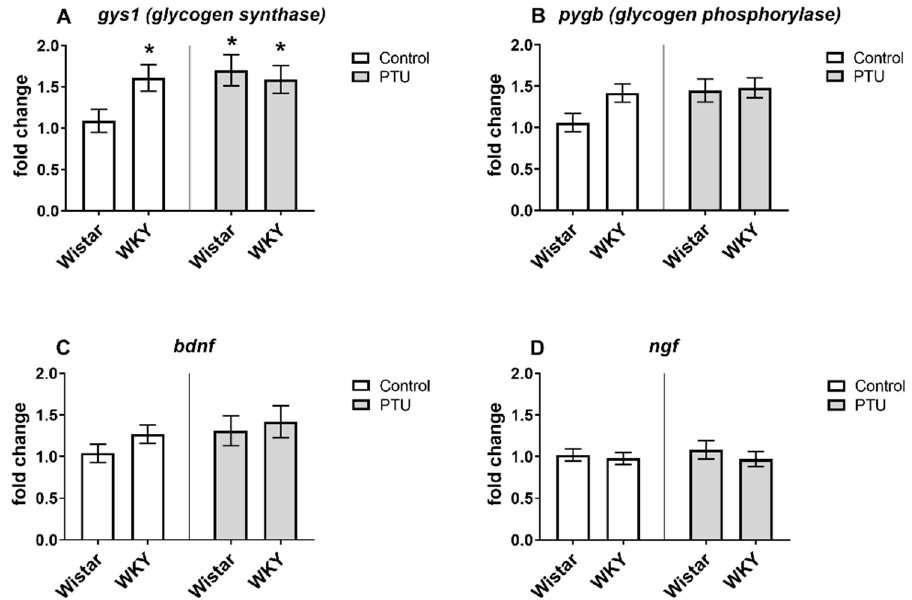
Figure 5. The effects of strain and PTU treatment on the gene expression of glycogen synthase 1 (gys1) ( A ), glycogen phosphorylase (pygb) ( B ), brain-derived neurotrophic factor (bdnf) ( C ), and nerve growth factor (ngf) ( D ) in the hippocampus. The results are expressed as the average fold change ± SEM. * p < 0.05 vs. the control group (Wistar rats). n = 9–10.